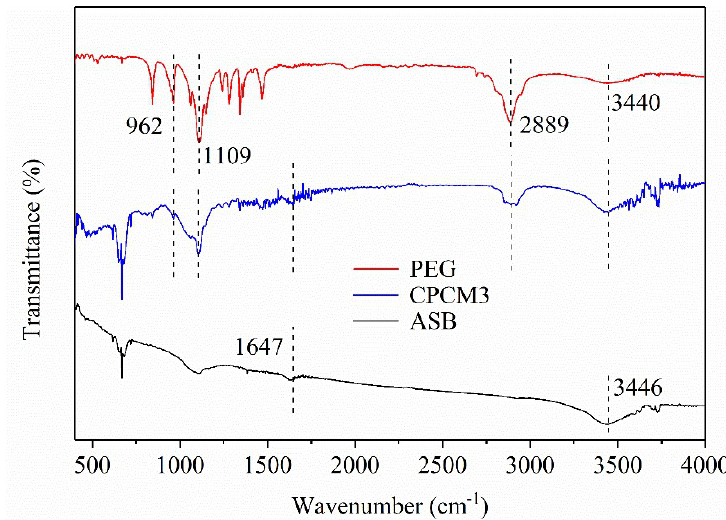
Figure 5. Fourier transform infrared (FT-IR) spectra of ASB, CPCM3 and PEG.